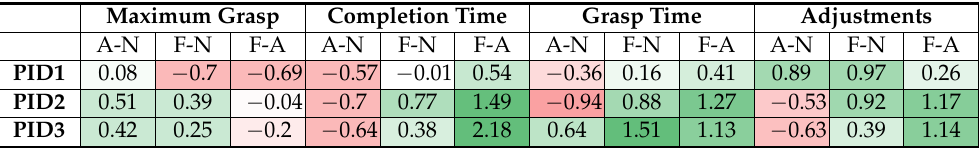
Table 2. Effect sizes for relative within-participant results (green shading represents a positive value, red shading represents a negative value, strength of shading represents the magnitude of value.